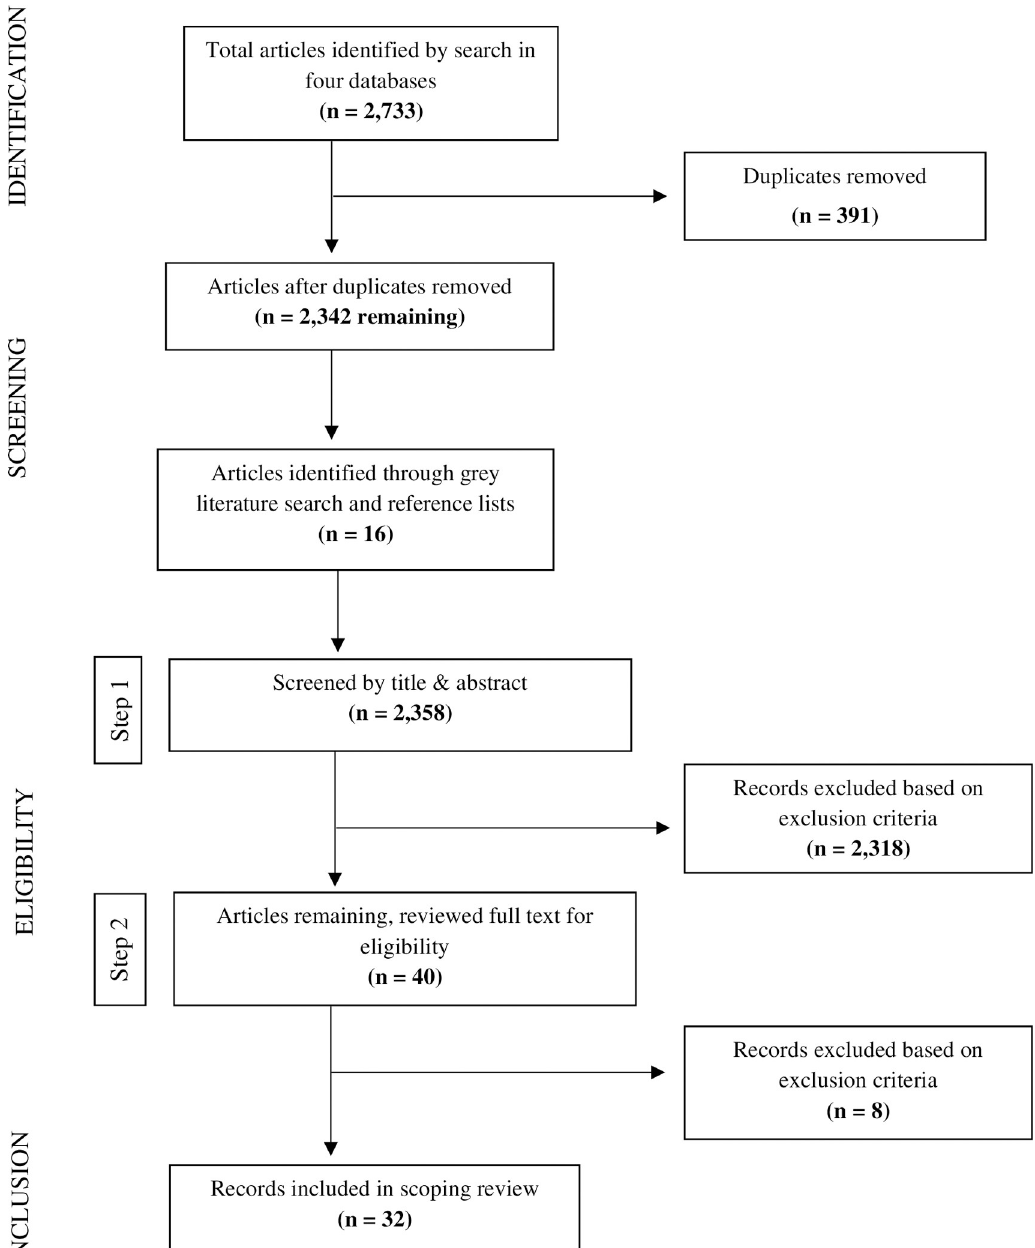
Fig 1. PRISMA flow diagram depicting the article selection